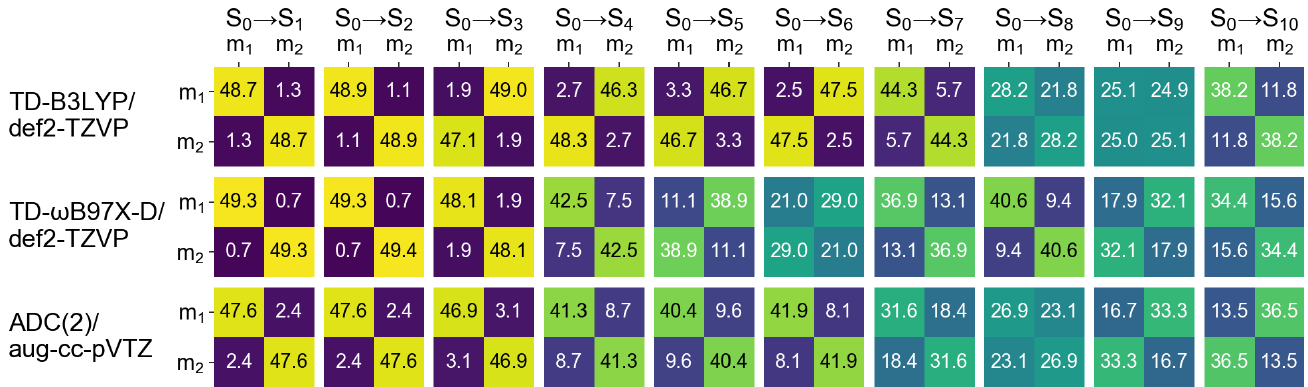
Figure 14. 5 F matrices for ten excited states of the optimized dimer calculated at the TD-B3LYP/def2-TZVP ( top row ), TD- ω B97X- D/def2-TZVP ( middle row ), and ADC(2)/aug-cc-pVTZ ( bottom row ) levels of theory. X , Y = m 1 ,m 2 ; m stands for